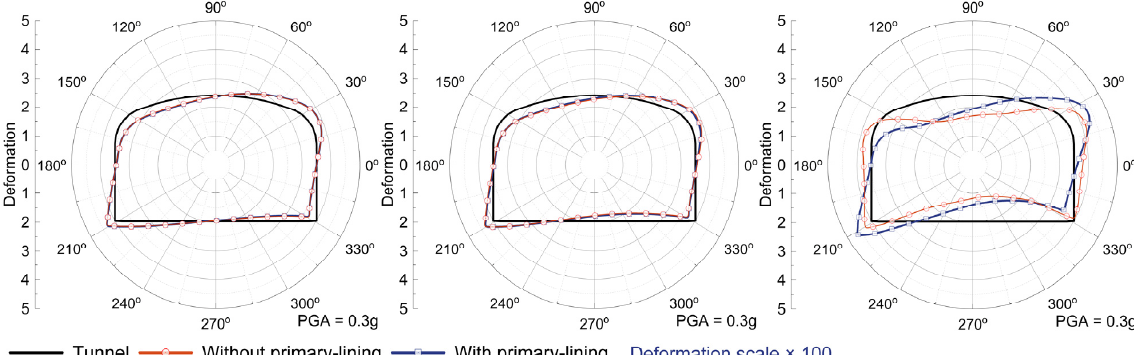
Figure 9 . The shape of deformed tunnel for time steps computed Figure 9. The shape of deformed tunnel for time steps